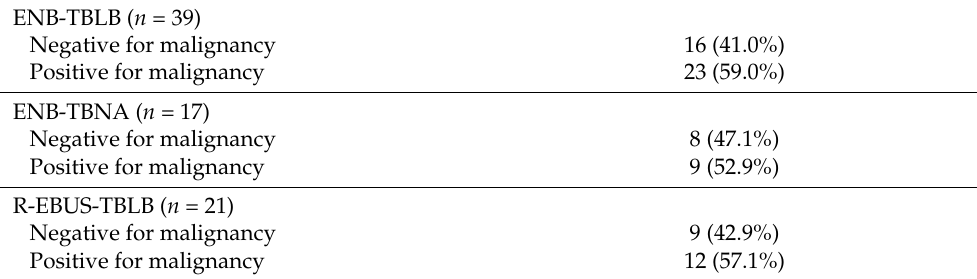
Table 2. Diagnostic results of ENB and R-EBUS-guided TBLB.